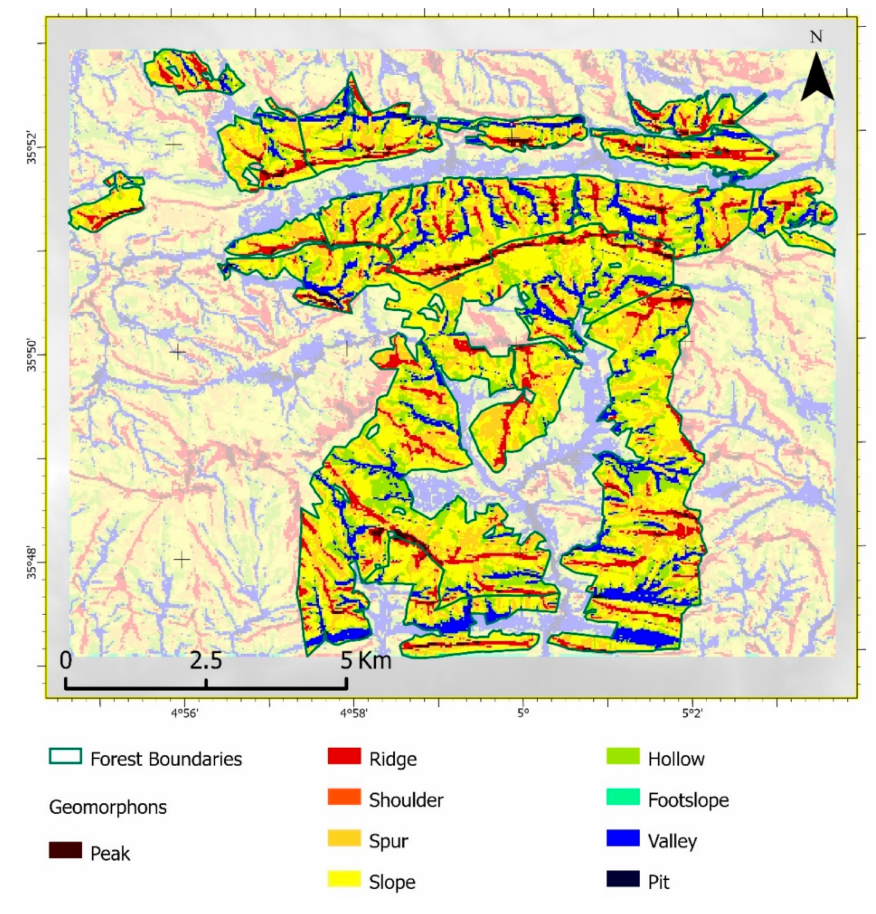
Figure 4. Map of geomorphon classes in the Ouled Hann è che forest.